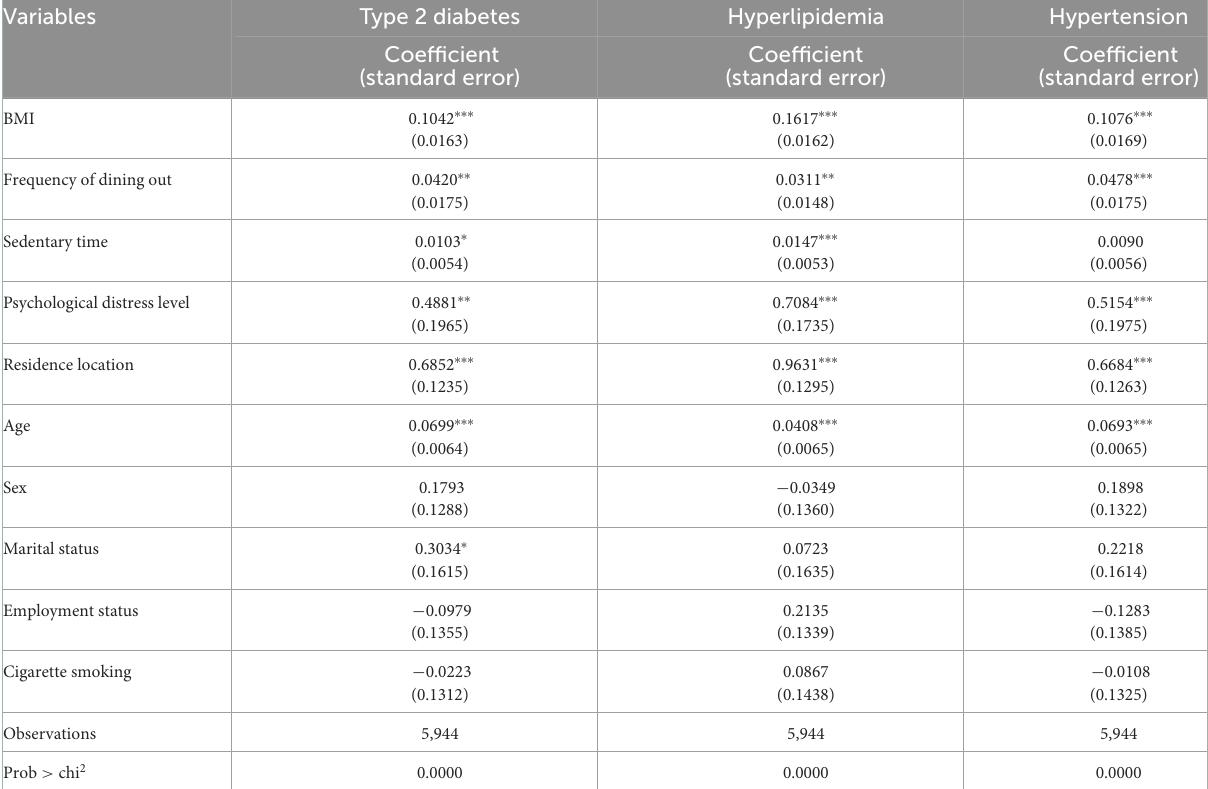
TABLE 3 Potential mediators of urban living on chronic